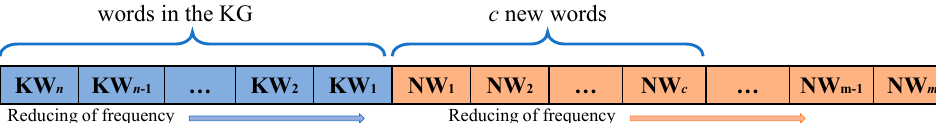
Figure 6. the Word Frequency Vector for Apriori. Figure 6. The Word Frequency Vector for